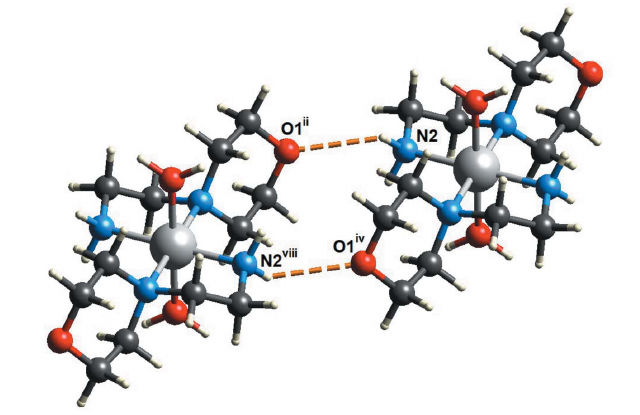
Figure 3 R 2 (14) ring motif formed between the two morpholine molecules through 2 very weak N—H (cid:2)(cid:2)(cid:2) O interactions (dotted lines). [Symmetry codes ii and iv as in Table 1. Symmetry code: (viii) (cid:4) x + 1, (cid:4) y , (cid:4) z + 1.]